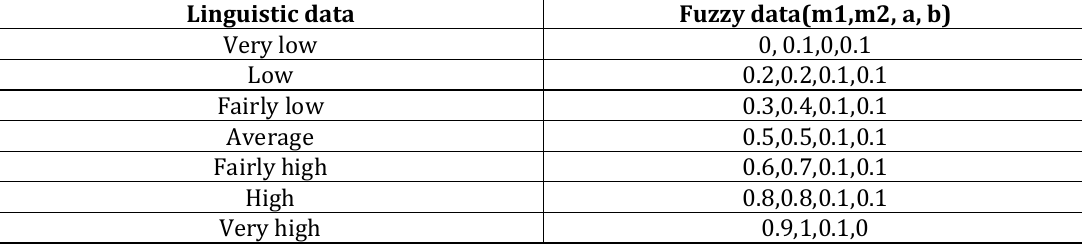
Table 2: The conversion of linguistic data to fuzzy data Linguistic data